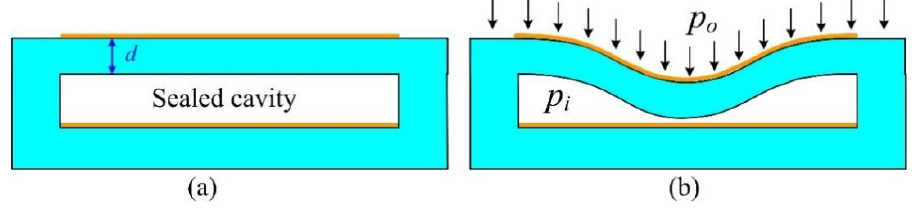
Figure 7. Pressure sensor model ( a ) before deformation ( b ) after